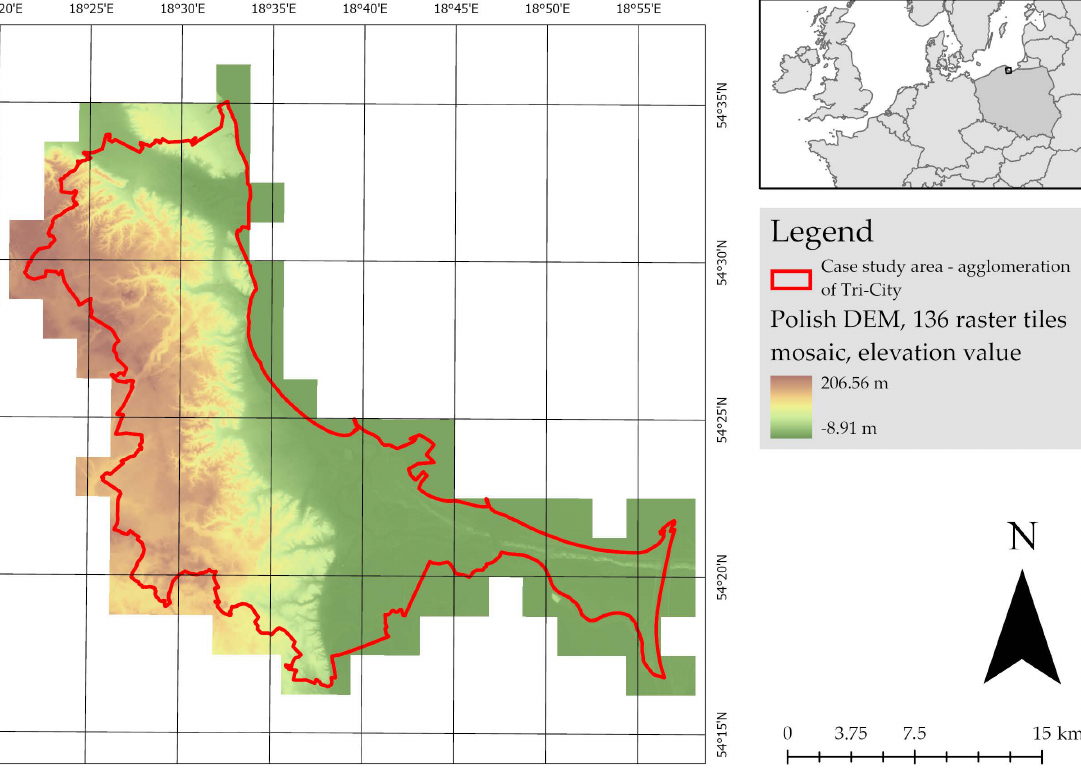
Figure 8. Polish DEM, 136 raster tiles mosaic. Source: own elaboration, on the basis of Polish DEM—Geoportal